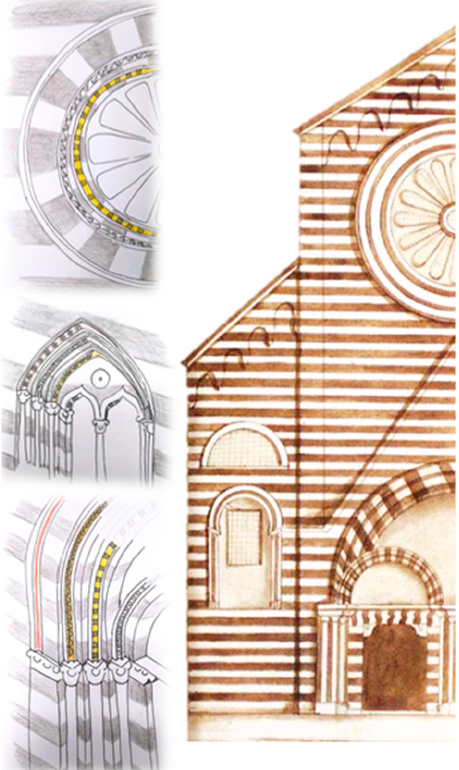
Figure 8. Inferred appearance of the façade, according to the data that emerged in the present study. On the left side, reconstructions of the decorative reliefs of a rose window, double arched windows and a splayed portal, and their colours. The possible positioning of the analysed fragments on the façade, along with its chromatic scheme, based on the paint relics is rendered with three virtual models. On the right hand side, for comparison, a reproduction of the drawing of the façade from the manuscript Epitaphia, sepulcra et inscriptiones cum stemmatibus marmorea et lapidea existentia in ecclesis genuensibus , by Domenico Piaggio, folio 12, courtesy of the Berio Library,